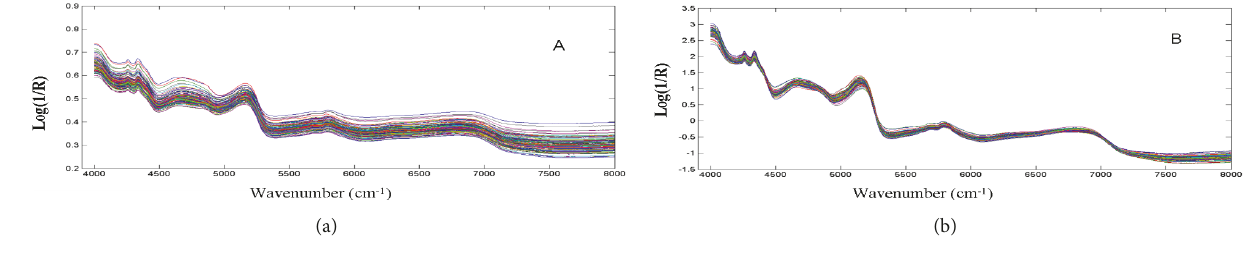
Figure 1: Raw NIR spectra of all samples and processed